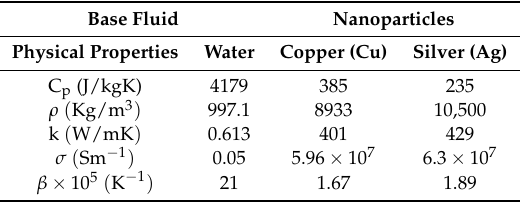
Table 1. Thermophysical properties of the base fluid and the nanoparticles [38]. Base